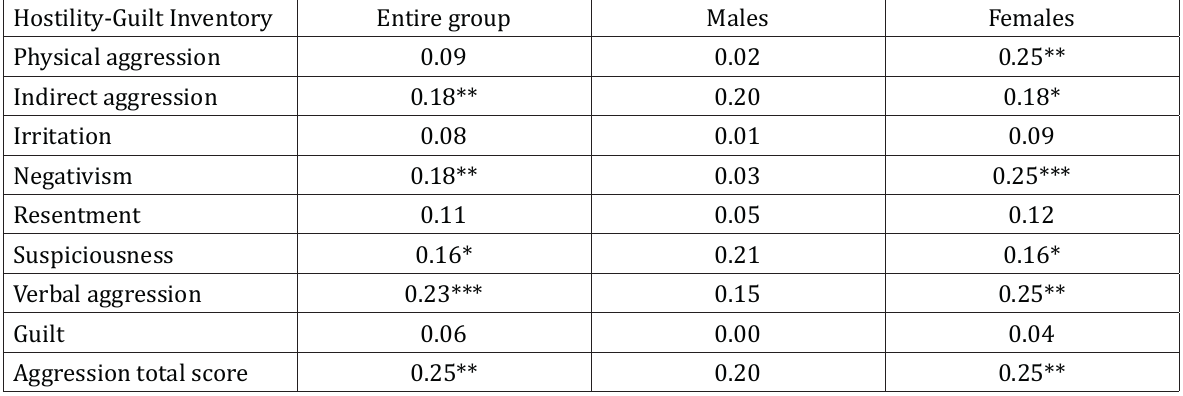
Table 4. Correlation coefficients between the participants' daily SNS usage times and their H-GI